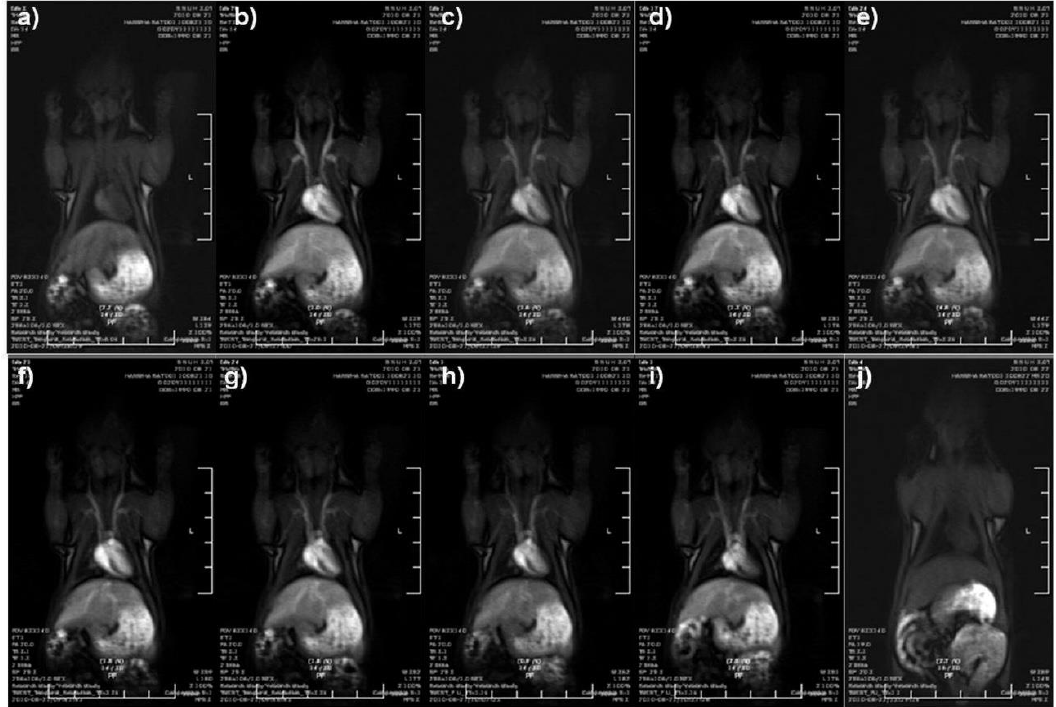
Figure 2. ESION-enhanced in vivo MR images with dynamic time-resolved MR sequence acquired at ( a ) 0 s ( b ) 30 s, ( c ) 1 min, ( d ) 2 min, ( e ) 3min, ( f ) 5 min, ( g ) 10 min, ( h ) 30 min, ( i ) 60 min, and ( j ) 1 day after the injection. Reproduced with permission from [87], published by ACS, 2011.